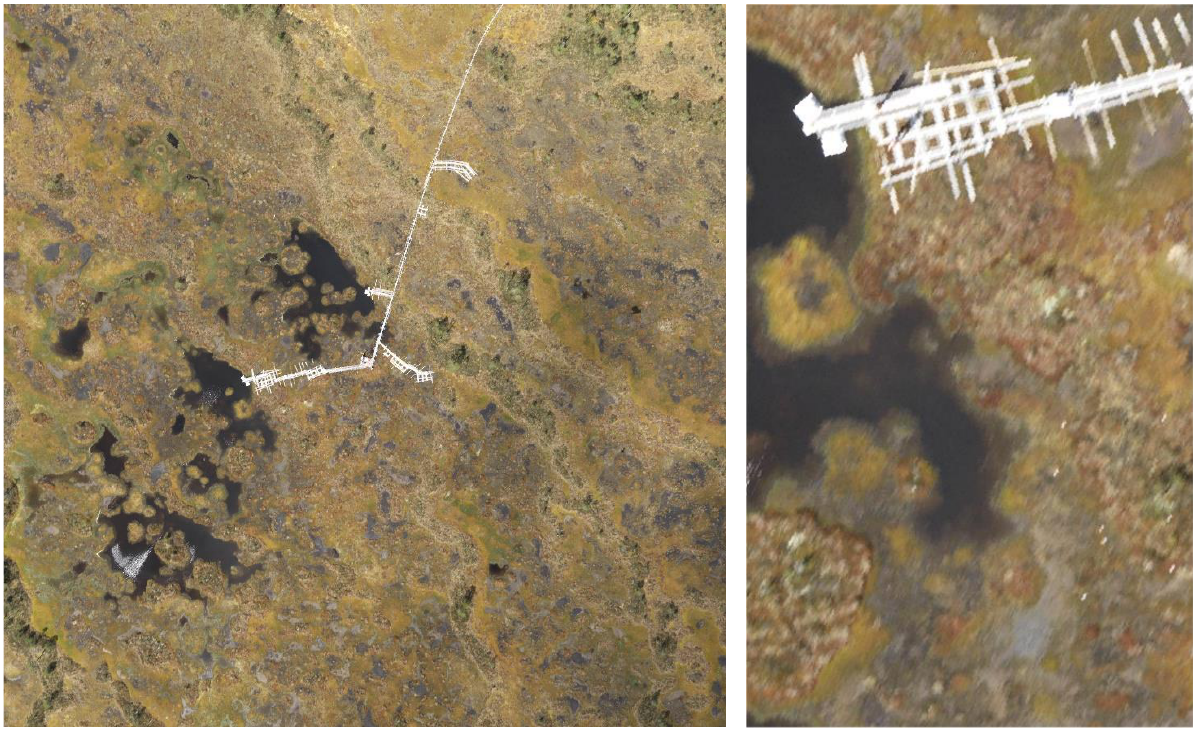
Figure 5. A 200 × 200-m aerial image from May 2013. The EC tower is in the centre (350999.7E, 6859303.5N in UTM35). The darkest surfaces are water (W). Greyish surfaces are mud-bottom hollows (MB). The shadows of 1−5-m-high pines are barely visible on the ridge hummocks. Green-yellowish depicts hollow (HO) and lawn (L) surfaces (Table 1). The sub-image on the right shows an area of 19 × 28 metres.